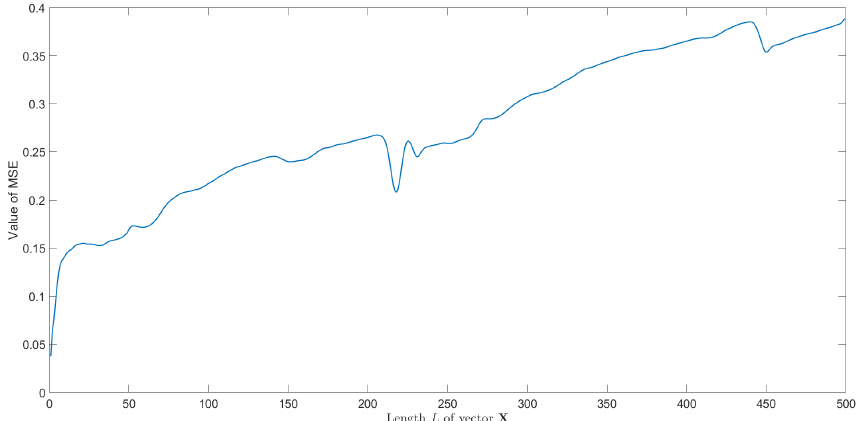
Figure 2. The MSE between the filter response and the undistorted signal as a function of the length L of the vector X